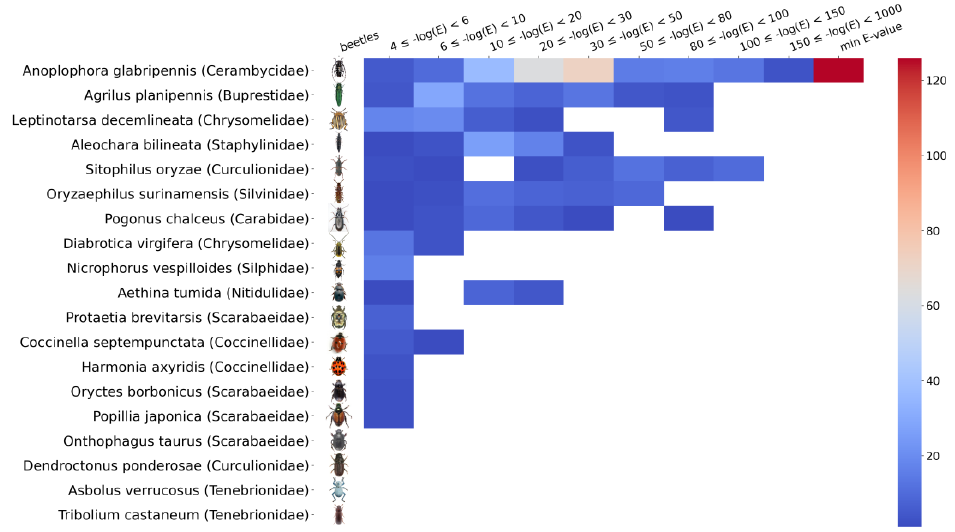
Figure 6. Distribution of bracovirus k-mers depending on e-value in reference genomes of several members of Coleoptera, including Leptinotarsa decemlineata . The color indicates the number of bracovirus k-mers identified within the specified e-value interval (BLASTn short). The absence of the color designates the absence of a match.